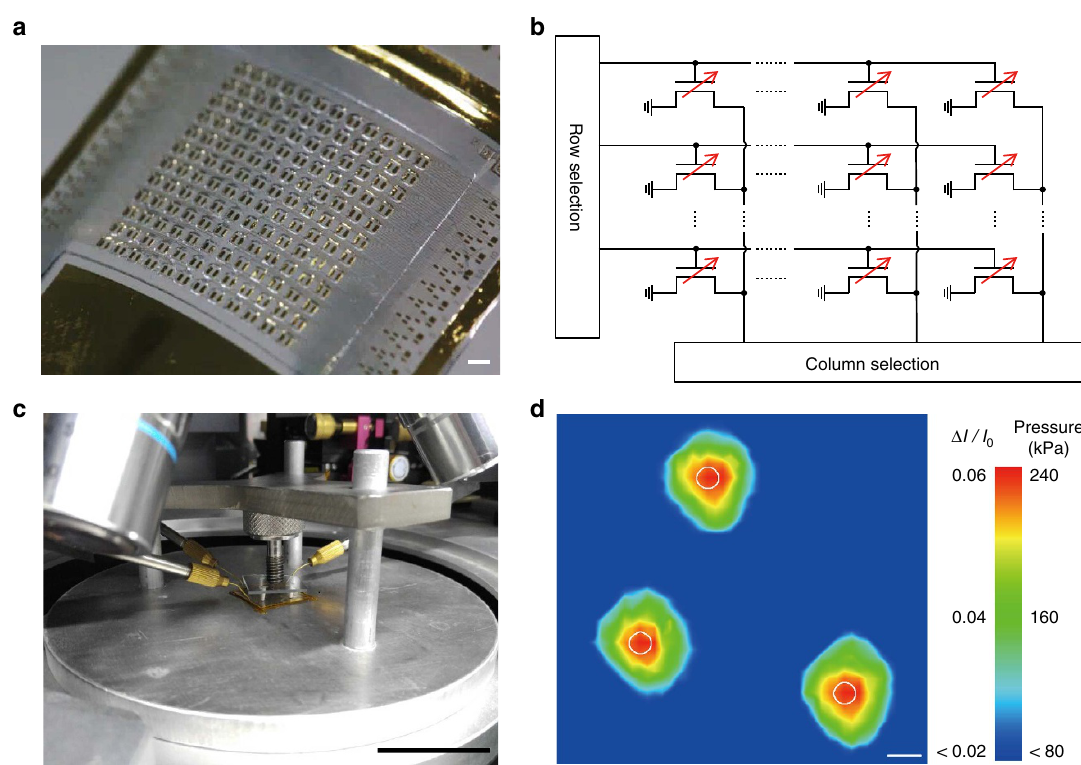
Figure 3 | Active-matrix pressure-sensitive FETarray for spatial pressure mapping. ( a ) 12 (cid:2) 12 active-matrix pressure-sensitive FETarray sample image before air-dielectrics are covered by top gate electrodes. The holes around source and drain electrodes which form air-dielectric layer are clearly identified. Scale bar, 1mm. ( b ) Corresponding electrical circuitry for 12 (cid:2) 12 active-matrix sensor array which allows selective readout of electrical response. ( c ) Pressure mapping set-up in probe station with the pressing machine on tripod structure which delivers the pressure to the 50 (cid:2) 50 pressure sensor array. Scale bar, 5cm. ( d ) Contour plot showing the resultant drain current change indicating how pressure was spatially distributed. White circles show the location of tripod legs and B 240kPa is loaded on each spot. Scale bar,